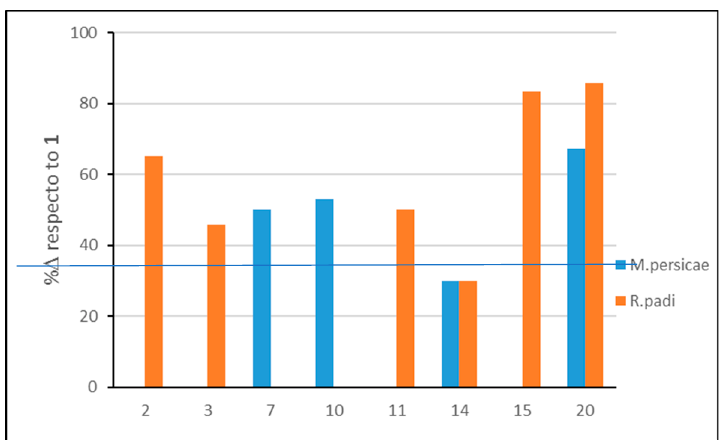
Figure 6. Increment (% Δ ) in antifeedant activity (EC 50 values) of derivatives 2 , 3 , 7 , 10 , 11 , 14 , 15 , and 20 with respect to 1 .